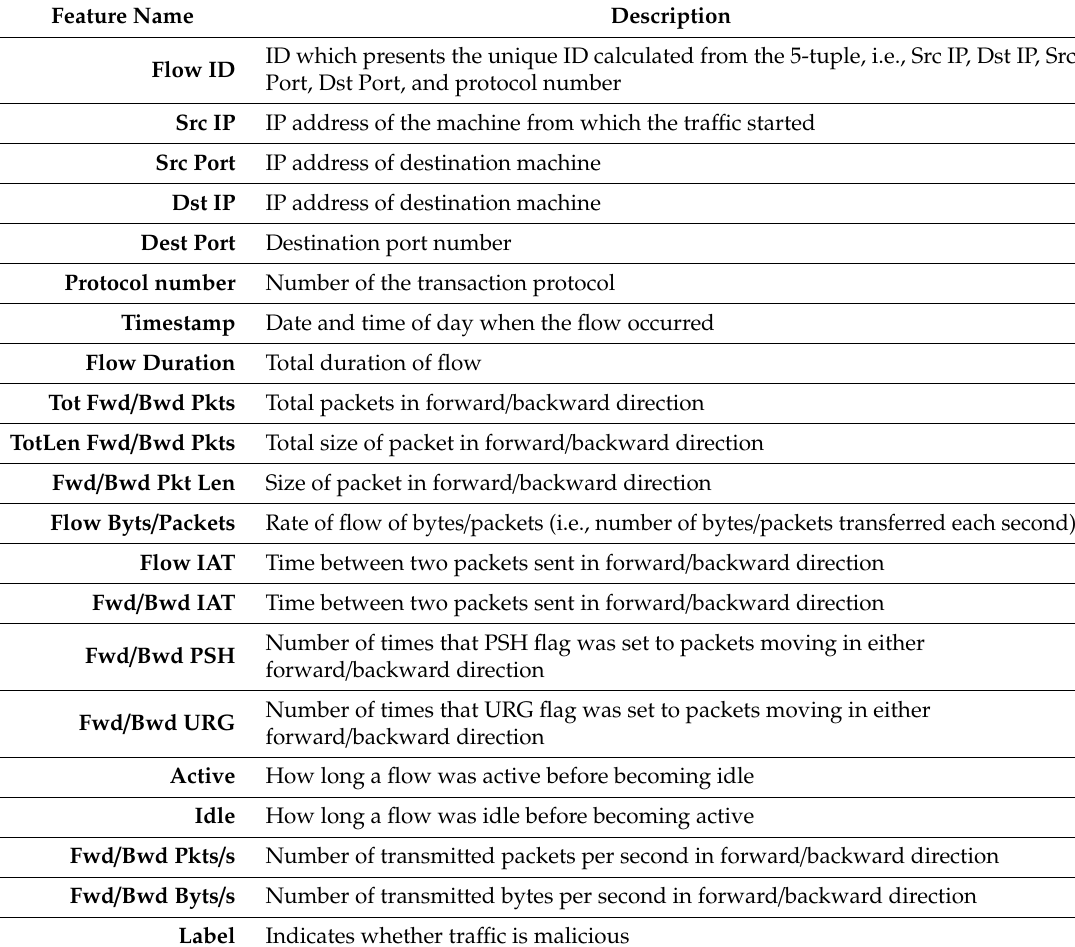
Table 1. GTCS Dataset extracted